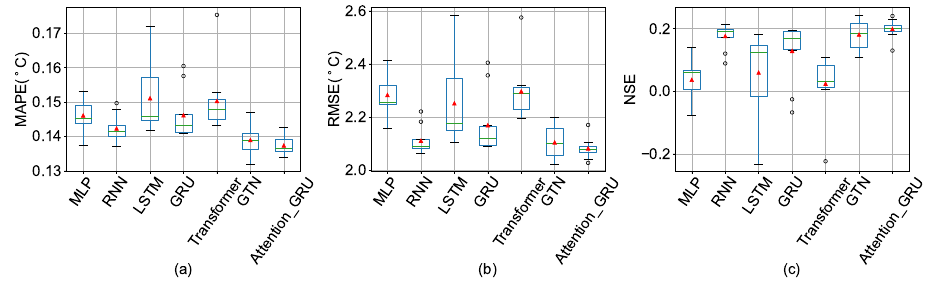
Figure A4. The box plot of ten experiment results of deep learning models under the KNN. ( a ): The results of MAPE. ( b ): The results of RMSE. ( c ): The results of NSE.